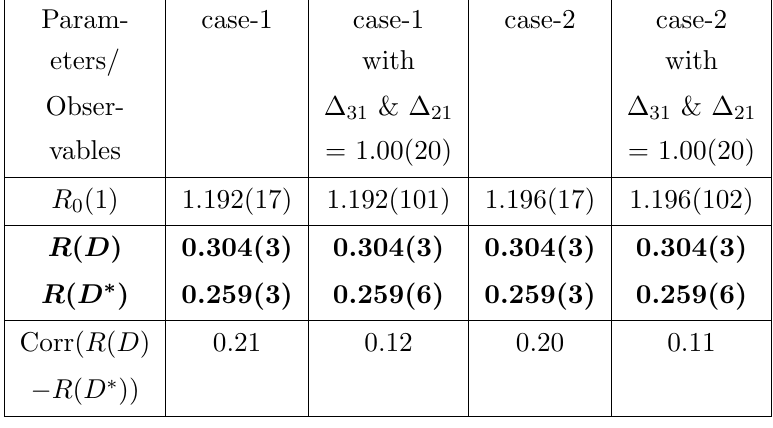
Table 7 . The SM predictions for R ( D ) and R ( D (cid:3)